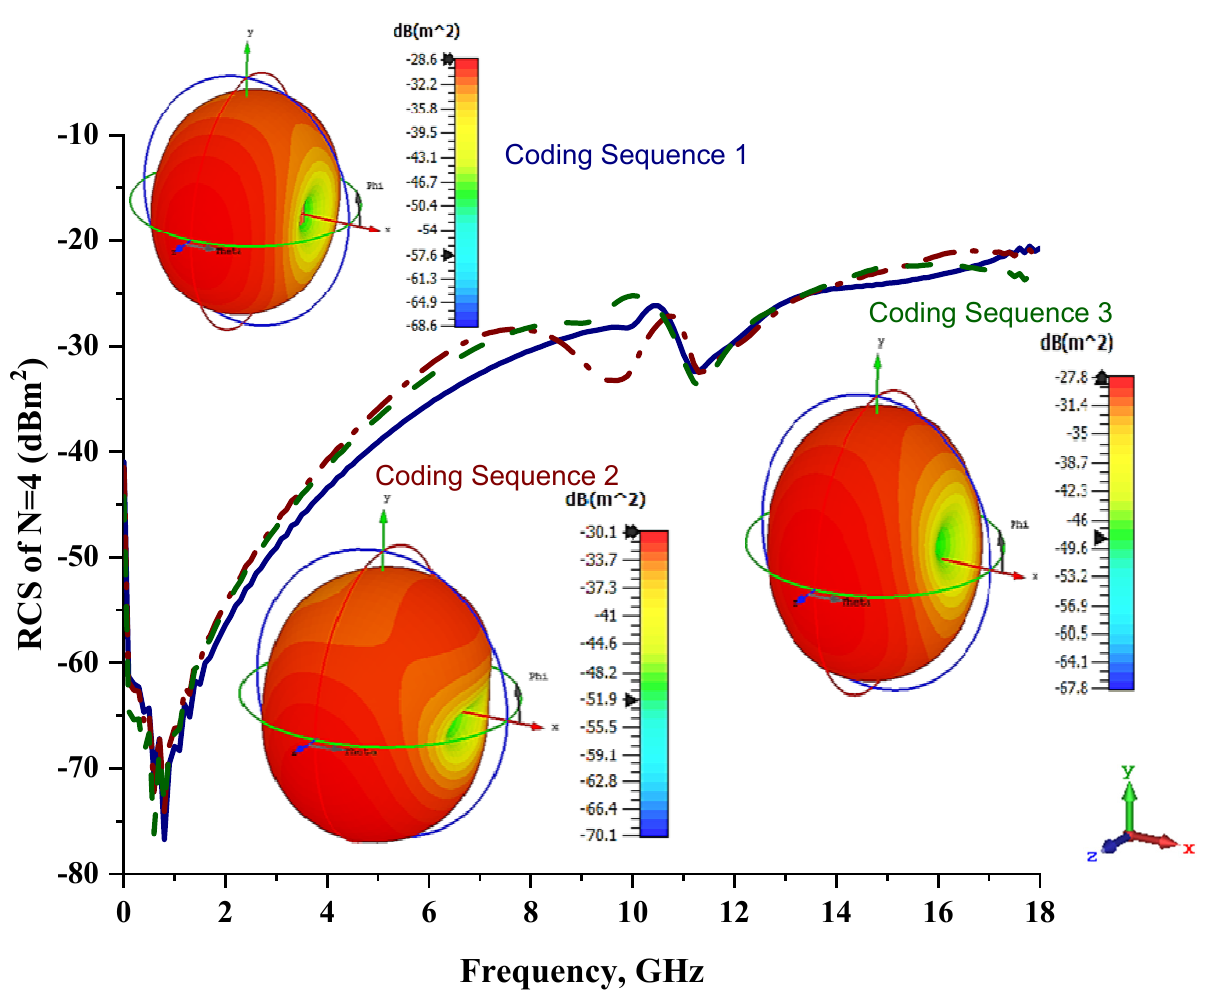
Figure 6. Monostatic RCS and bistatic scattering patterns (at 8 GHz) of three different coding metamaterials with four lattices. Table 6. Coding sequences of n = 4 for each row.